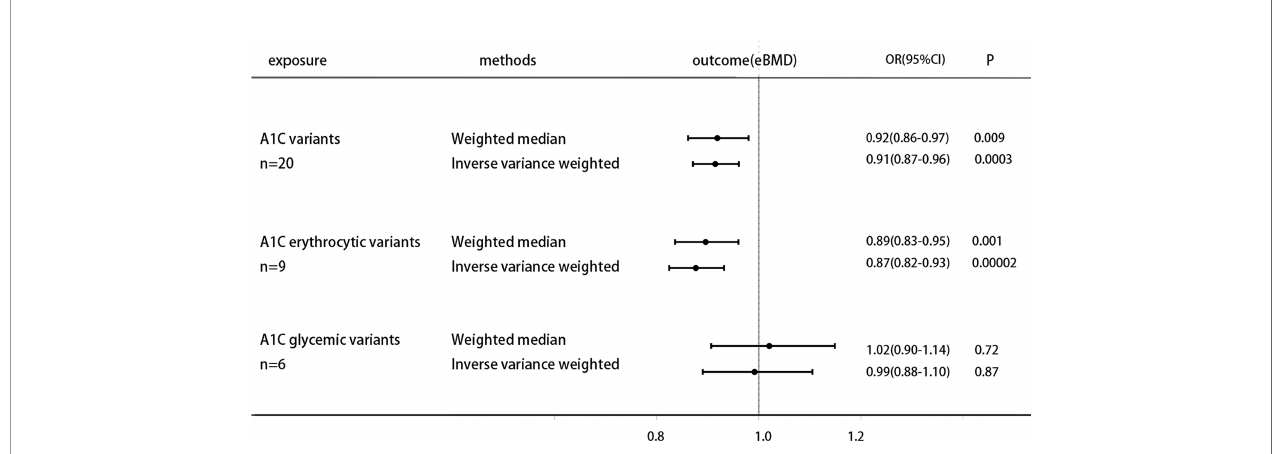
FIGURE 1 | Causal effect on eBMD in UKBB of increased A1C instrumented by all A1C-associated genetic variants, glycemic-only A1C variants, and erythrocytic- only A1C variants. MR analysis were performed by the IVW and WM methods. Effect estimates are OR of eBMD per %-unit increase in